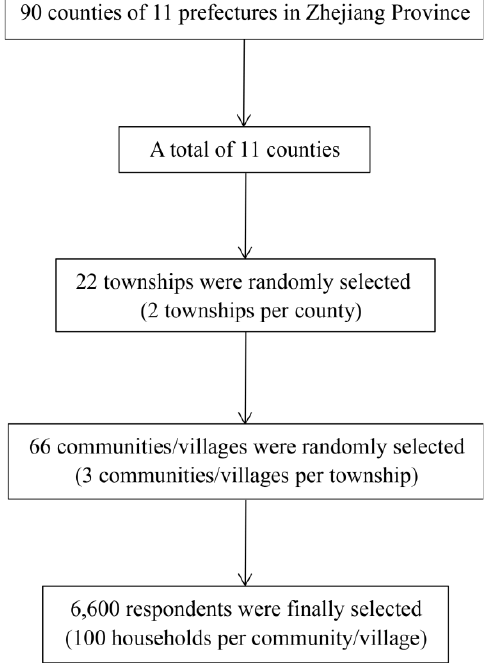
Figure 1. The multistage sampling process of the survey in Zhejiang Province, China from October 2018 to December 2018.